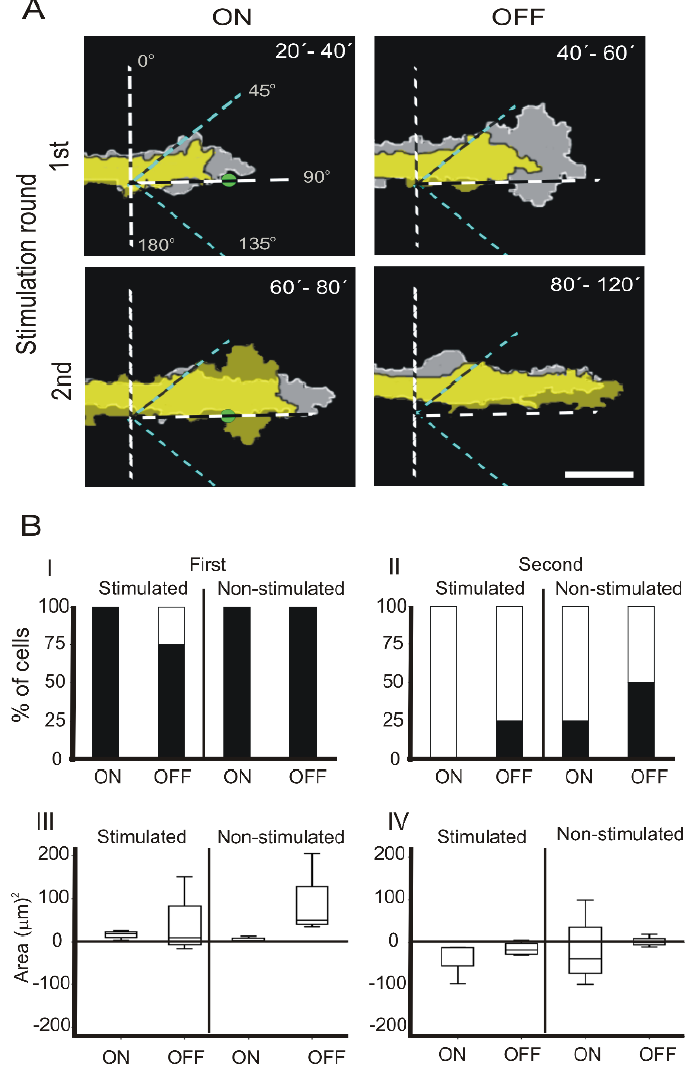
Figure 2. PC12 growth cone projections with fixed laser position at the on and off period of laser stimulation. ( A ) Similar to Figure 1B, with static laser. Stimulated quadrants, 45–135 ◦ , delimited with blue dotted lines, and non-stimulated zones. Green dots mark the position of the laser during all the stimulation period. ( B ) Similar to Figure 1C. The scale bar in A represents 15 µ m. In the second round of laser stimulation, the growth cone continued to advance in some cells, although the total area decreased due to the narrowing to the cell at the back of the growth cone once the laser was off (Figure 2A, 2nd). When we compared the per- centage and the median of the differences of the projected areas, we found the following results.